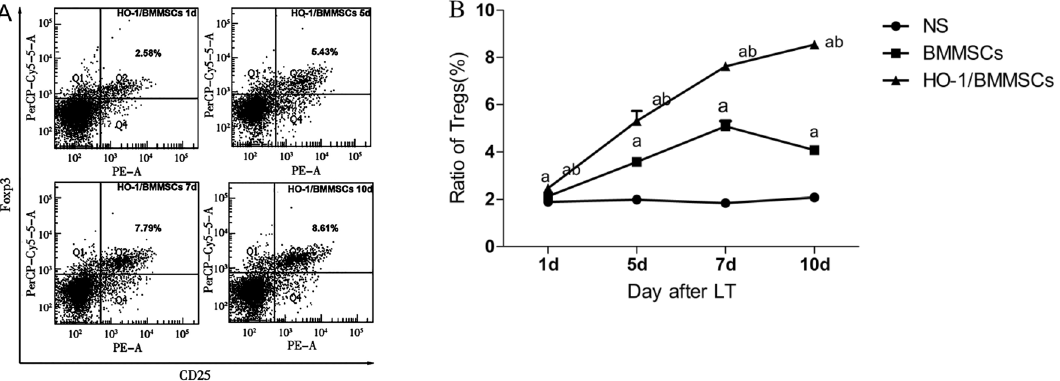
Figure 4. The level of Tregs in recipient spleens. ( A ) Scatter plot showing Tregs in the spleen in the HO-1/ BMMSC group at different time points after the operation. ( B ) Treg ratios of rats in each group (compared with the NS group, P < 0.05; compared with BMMSC group, P <